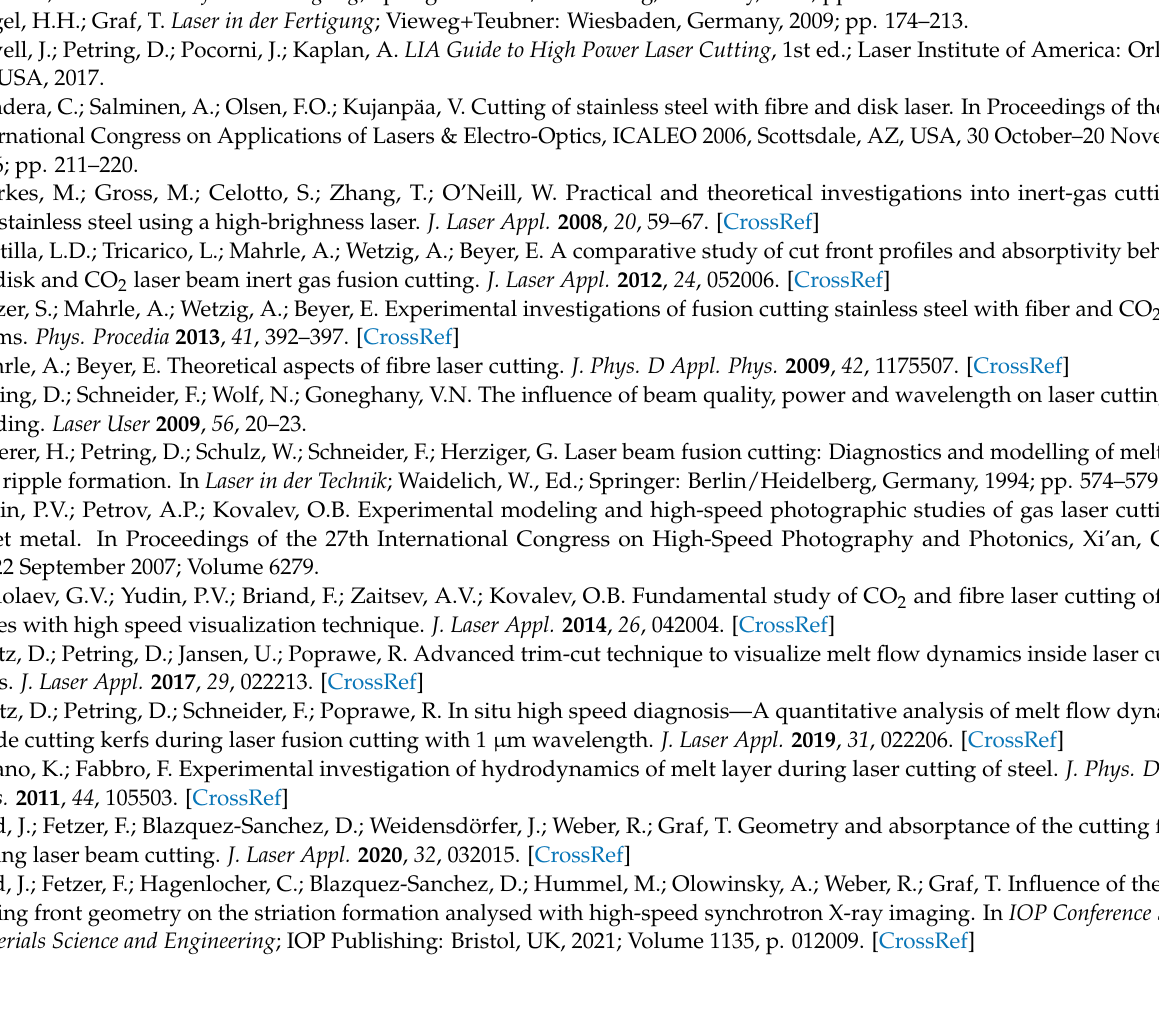
Figure A2. Residue convergence plot.